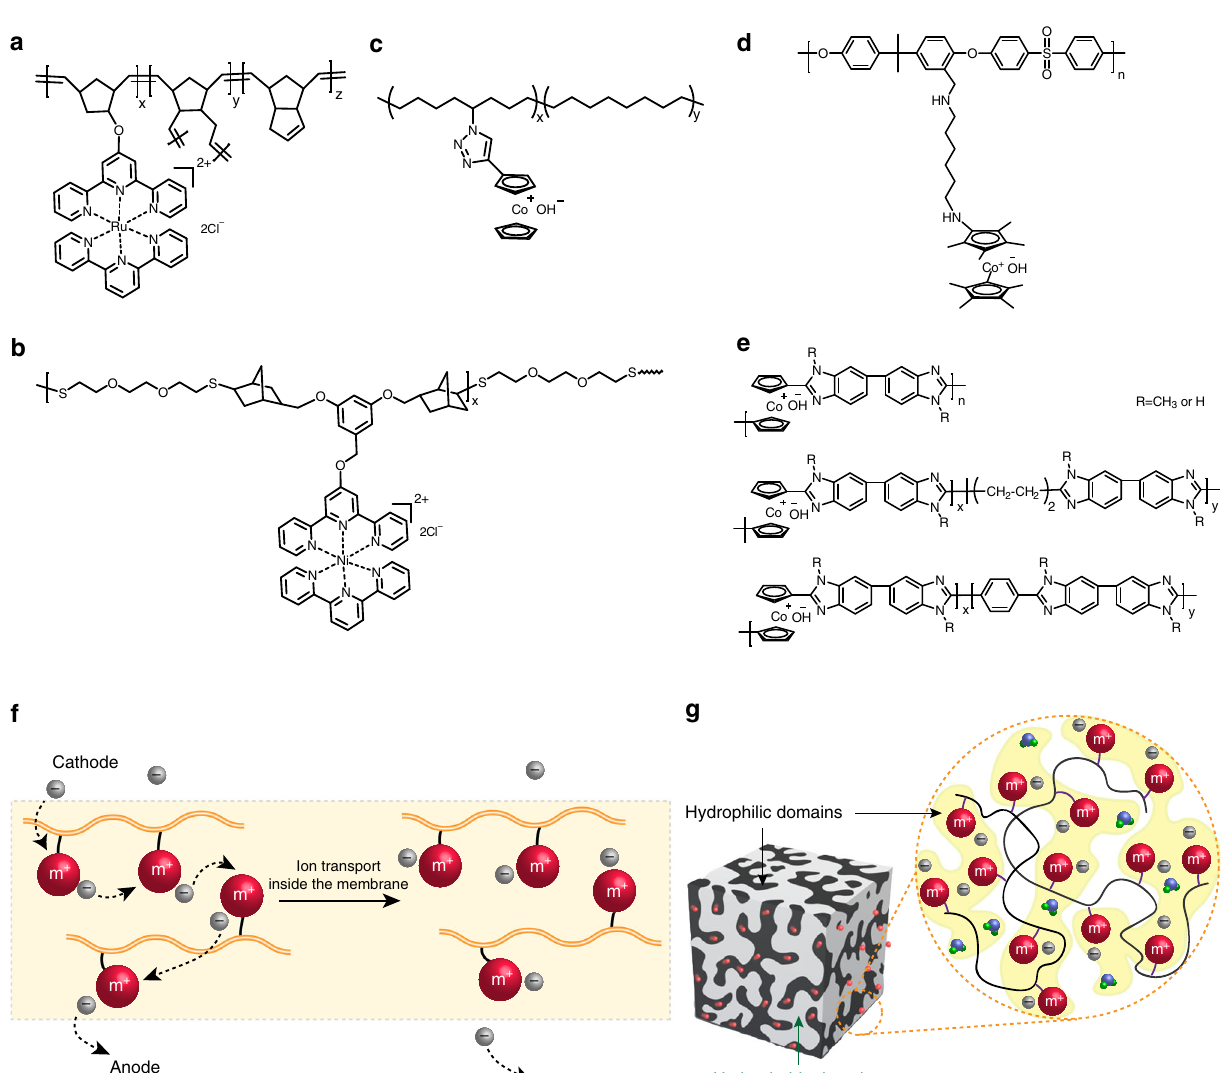
Fig. 8 Metallo-polyelectrolytes for ion transport. Synthesis of metallo-polyelectrolytes by ROMP with metal complexes at the side-chain: a heteroleptic bis (terpyridine) Ru(II) complex; 23 b nickel-containing complex; 154 c cobaltocenium cation 24 . Metallo-polyelectrolytes by polycondensation: d permethyl cobaltocenium-containing polysulfone; 151 e cobaltocenium-containing polybenzimidazole; 150 f illustration of single ion site migration inside alkaline anion- exchange membranes; g A highly preferred phase separated morphology containing continuous hydrophilic ion transport channels and a hydrophobic matrix 155 , adapted with permission from ref. 155 . Copyright © 2017, American Chemical